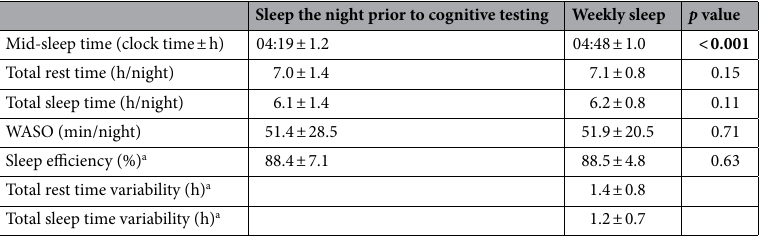
Table 2. Sleep measures for participants with valid weekly sleep and valid sleep measured the night prior to cognitive testing. Results presented as mean ± standard deviation, unless otherwise noted. p values are the result of paired t-tests comparing sleep the night prior to cognitive testing to weekly sleep. Boldface type indicates significant differences. WASO wake after sleep onset. a Results presented as median ± interquartile range due to skewed